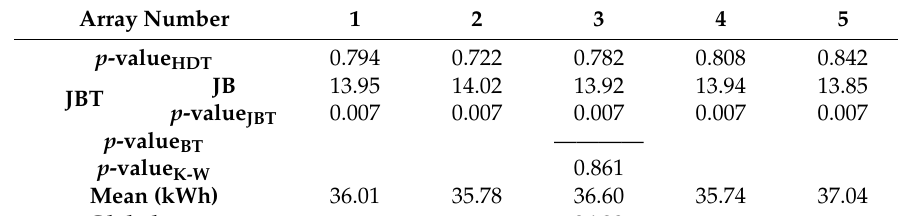
Table 5. p -Value of HDT, JBT, BT, (KW) for the energy distribution of the arrays, and mean in kWh and spread with respect to the global mean for six-months analysis (January–June).